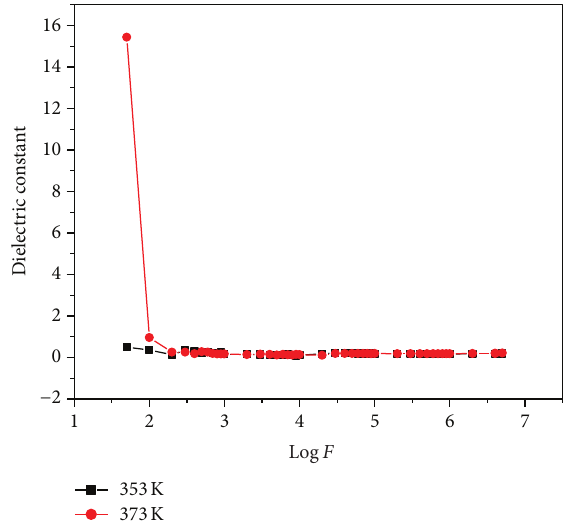
doped ninhydrin. 2+